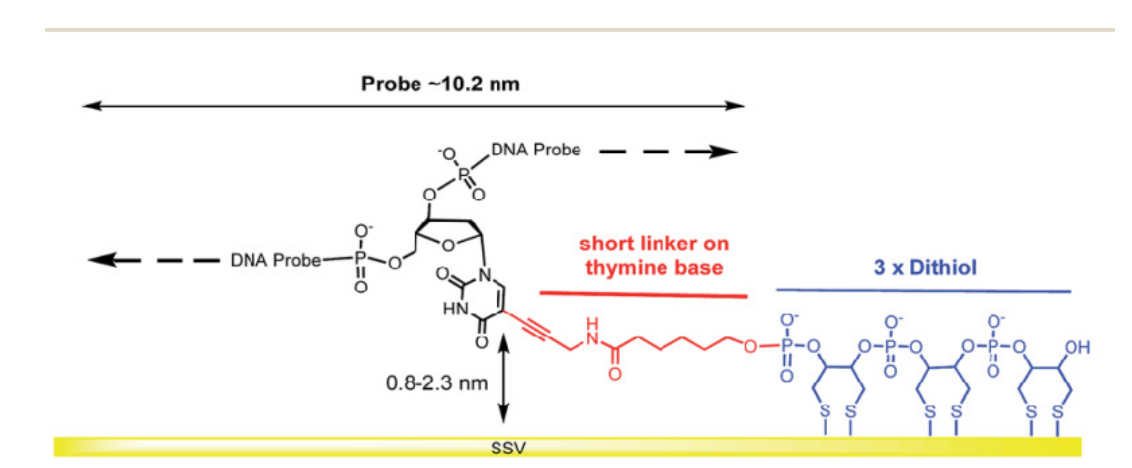
15 of 28 Figure 9. ( A , B ) Self-assembled monolayer ssDNA probes on the gold electrode surface-based dithiol groups. The relative sizes of gold electrodes, dithiol groups, and ssDNA chains are not to scale. This makes more stable ssDNA probes than immobilized ssDNA probe-based mon-